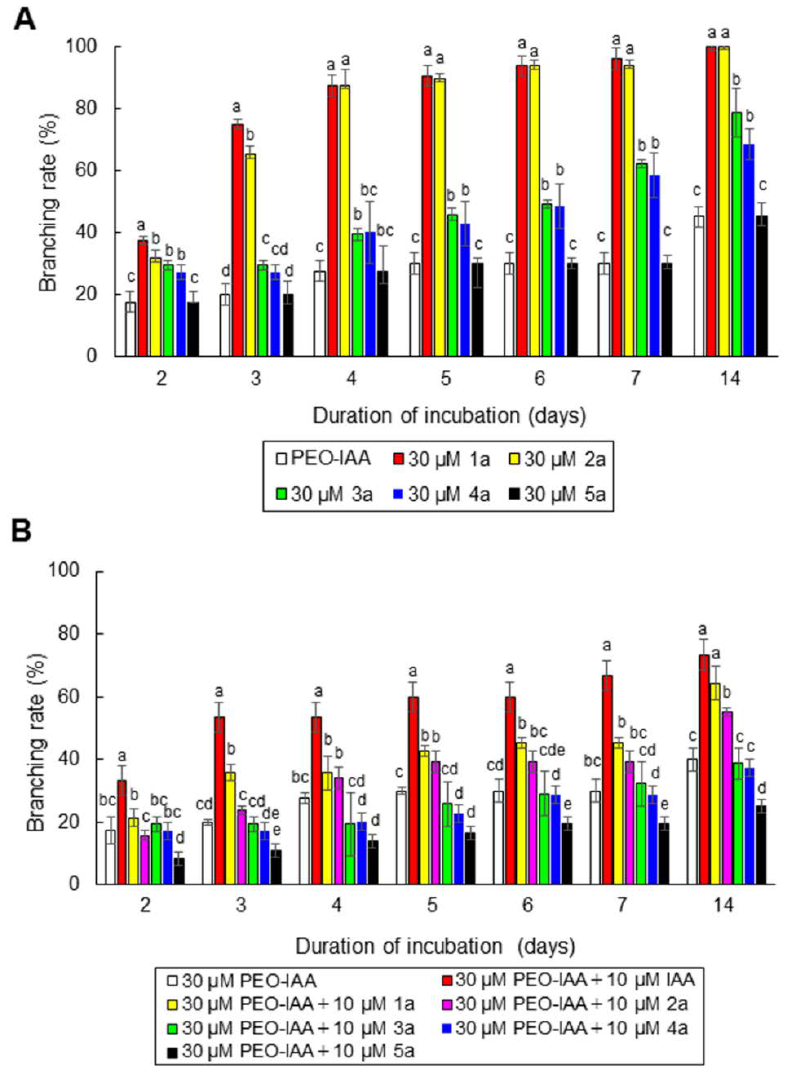
Figure 7. The effects of auxin and the auxin-antagonistic activity of 5-alkoxy-IAAs in N. yezoensis . ( A ) Comparison of the effects of 30 μM PEO-IAA and 30 μM 5-alkoxy-IAAs on the production of side branches. Side branch formation was observed in single-celled conchocelis cultured with each chemical for 2 weeks, and the number of conchocelis with branching was counted by microscopy observation at 2, 3, 4, 5, 6, 7, and 14 days to calculate the branching rate. ( B ) Activities of 5-alkoxy- IAAs. Isolated conchocelis cells were incubated in the presence of auxin derivatives 1a to 5a for 2 weeks, and the effects of these 5-alkoxy-IAAs on side branch formation were observed using a microscope at 1, 2, 3, 4, 5, 6, and 7 days. Error bars indicate the standard deviation of triplicate independent experiments ( n = 3), and different lowercase letters denote significant differences in branching rate, as determined by Tukey’s test ( p < 0.05) for each set of incubation times.